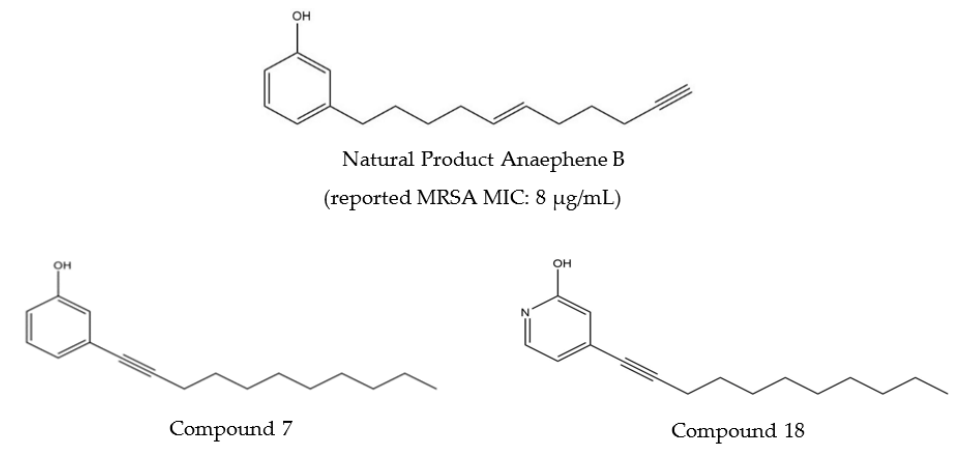
Figure 1. The three compounds tested in this study adapted from [10,11].